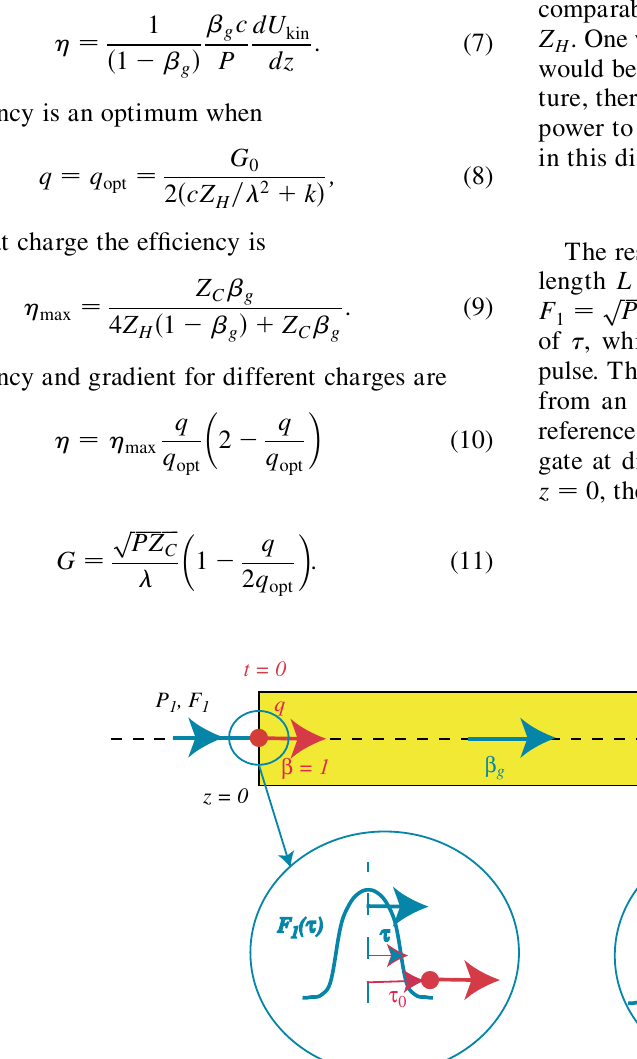
FIG. 2. (Color) A beam bunch and accelerator structure of length L . P and F are the corresponding fields. The time coordinate (cid:24) is shown with (cid:24) > 0 to the right of the center line. The mode, and F 1 2 ahead of the center of the laser pulse at z (cid:1) 0 and (cid:24) electron bunch is (cid:24) 0 to be constant for the length of the